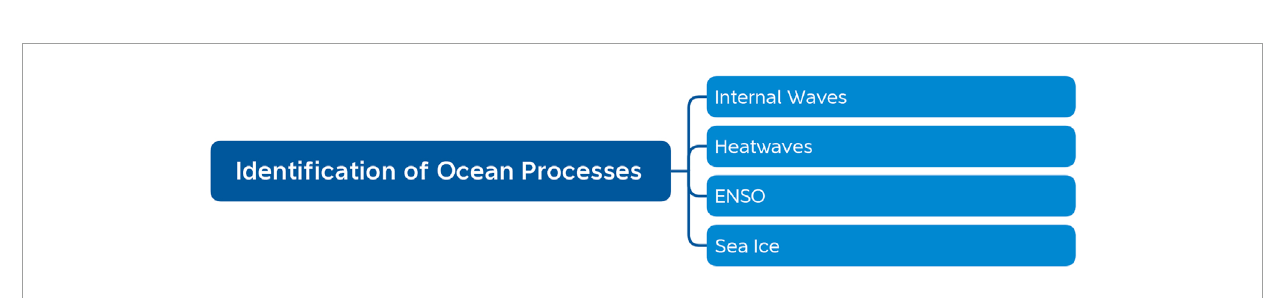
FIGURE 3 The Identification of Ocean Phenomena. This section describes four ocean phenomena (internal waves, heatwaves, ENSO, and sea